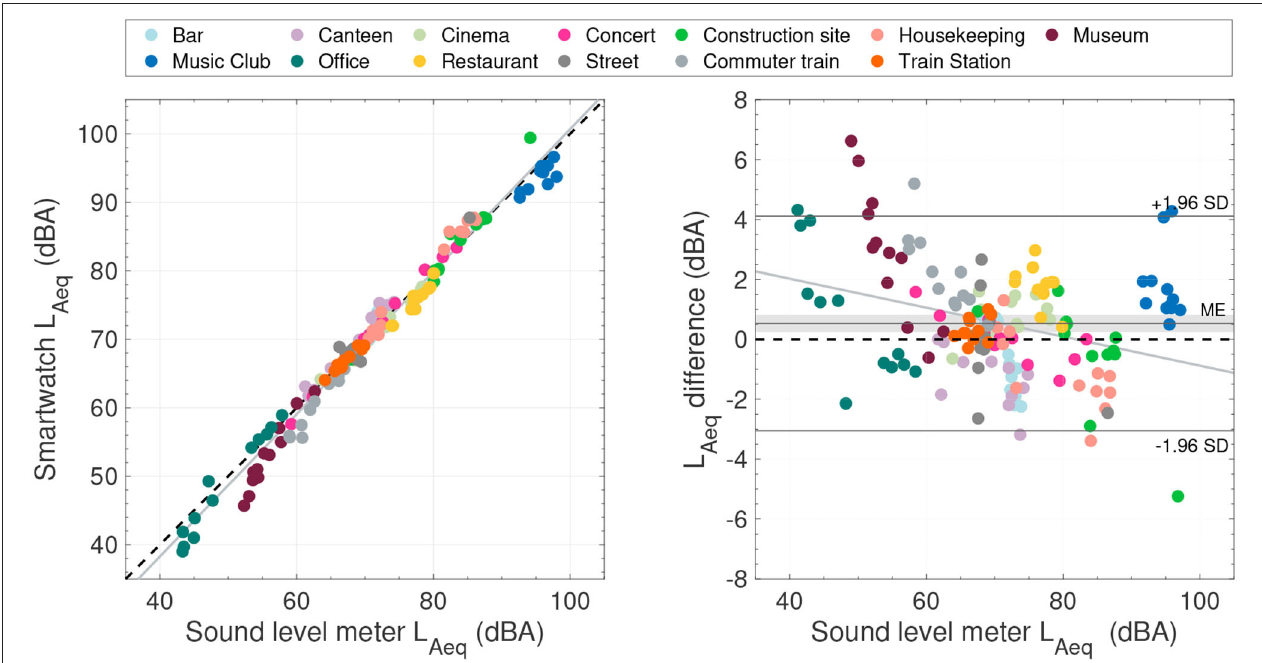
FIGURE 4 | (Left) Scatter plot comparing the L Aeq sample blocks between the sound level meter and the smartwatch. The black dashed line indicates identical measurements. (Right) Bland-Altman plot using the sound level meter as reference. The gray-shaded area indicates the 95% confidence interval of the mean error (ME). In both plots, the gray lines represent the least-squares regression line. The measurement settings are color encoded.